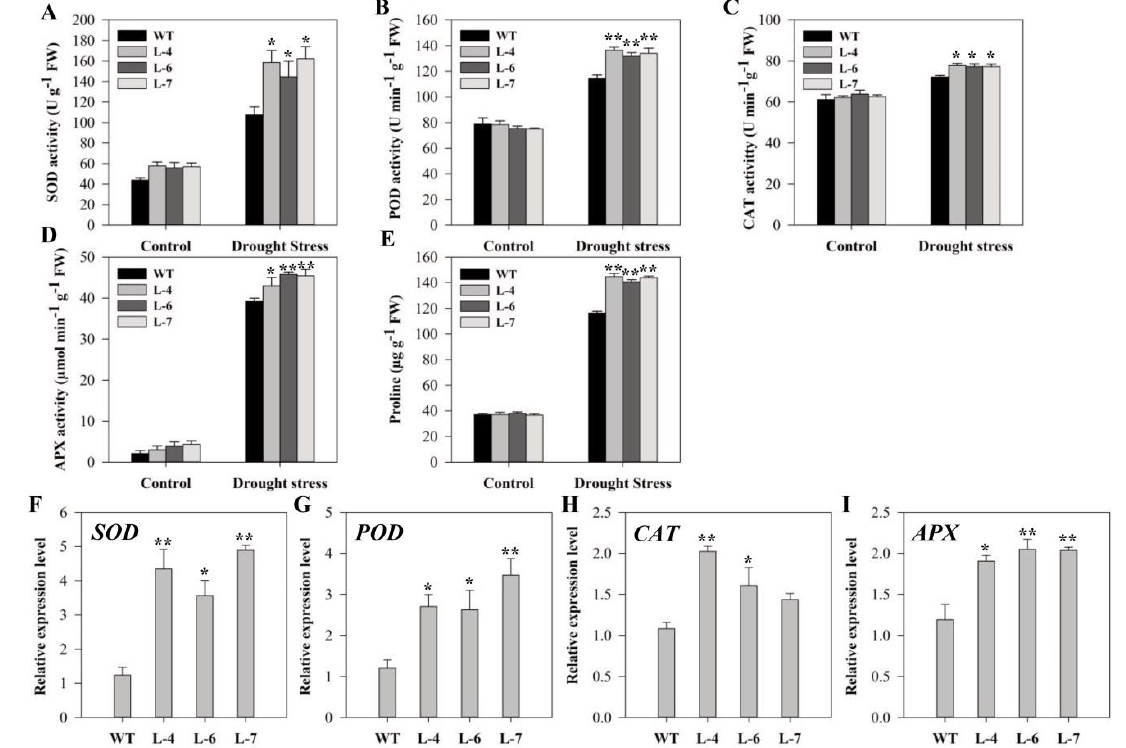
Figure 10. Comparison of enzymatic activity and relative expression of stress-responsive genes in wild-type and transgenic plants under normal and drought stress conditions. ( A – D ) Activity of SOD, POD, CAT, and APX, respectively. ( E ) Proline content and expression analysis of ( F ) SlSOD , ( G ) SlPOD , ( H ) SlCAT , and ( I ) SlAPX . Six-week old seedlings of WT and transgenic lines were subjected to drought stress by withholding water supply for 15 successive days and well-watered plants (watered every alternate day) served as a control. Data represent mean ± SE of three biological replicates. **, * significant level differed at p < 0.01 and p < 0.05, respectively.